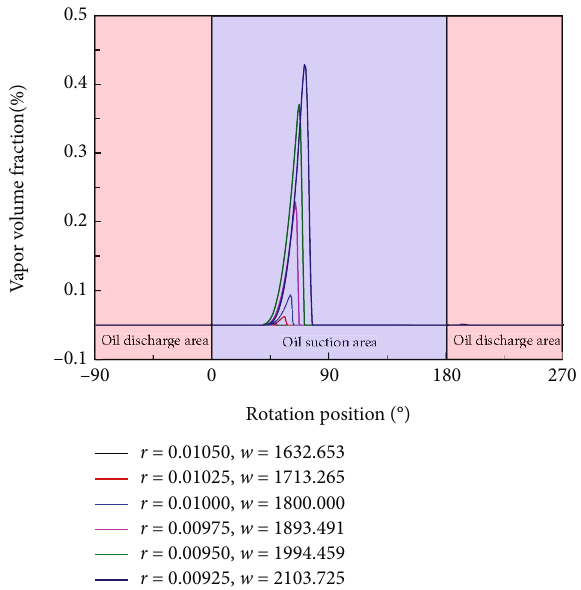
Figure 18: The curves of the vapor volume fraction in the plunger chamber with di ff erent plunger chamber radii and rotation speeds.